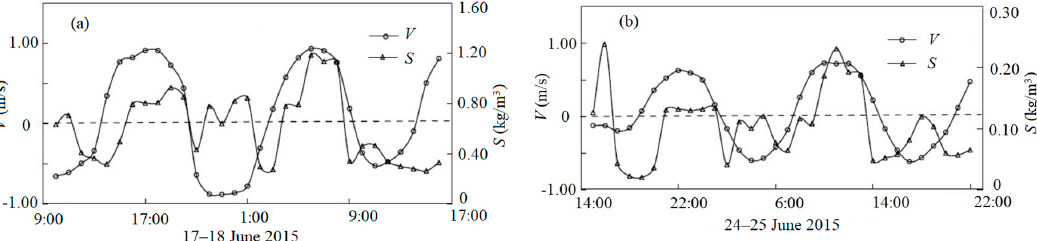
Figure 4. Station FS2, V – S relationship for spring and neap tides: ( a ) Spring tide; ( b ) Neap tide.